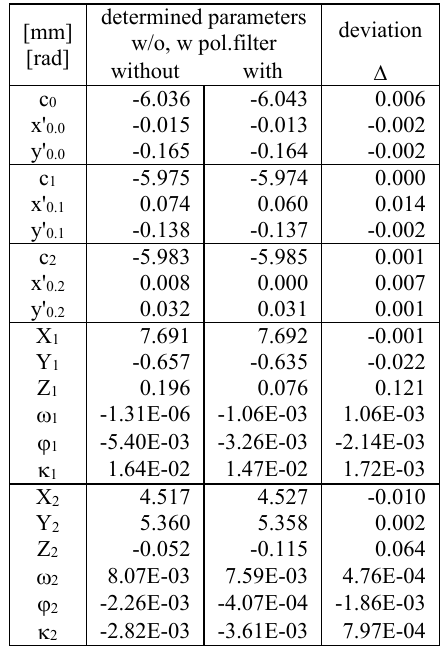
Table 3. Interior and relative orientation parameters with and without polarising filters and their deviations; the deviations are calculated with exact values and rounded.